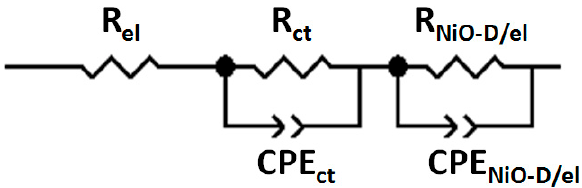
Figure 10. Model of the equivalent circuit for the fitting of the EIS data recorded at the potential of open circuit of three-electrode cell with dye-sensitized NiO as the working electrode. R el : the sum of all the resistances due to the circuital elements except the working electrode; R ct : resistance of the charge transfer between the NiO substrate and the dye; CPE ct : element of the constant phase, which refers to the charge distribution at the NiO/dye interface during the process of the charge transfer between the NiO and the dye; R NiO-D/el : resistance of the charge transfer through the interface created by the sensitized electrode and electrolyte; CPE NiO-D/el : element of the constant phase, which refers to the charge distribution during the process of the charge transfer through the interface created by the sensitized electrode and the electrolyte. Figure 9. Model of equivalent circuit for the fitting of the electrochemical impedance spectroscopy (EIS) data recorded at the potential of the open circuit of three-electrode cell with the bare NiO as the working electrode. R el : the sum of all the resistances due to the circuital elements except the working electrode. R NiO/el : resistance of the charge transfer through the interface created by the bare NiO and the electrolyte; CPE NiO/el : element of the constant phase, which refers to the charge distribution during the process of the charge transfer through the interface created by the bare NiO and the electrolyte.